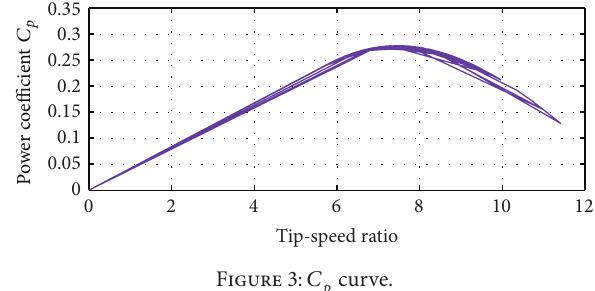
Figure 3: 𝐶 𝑝 curve.